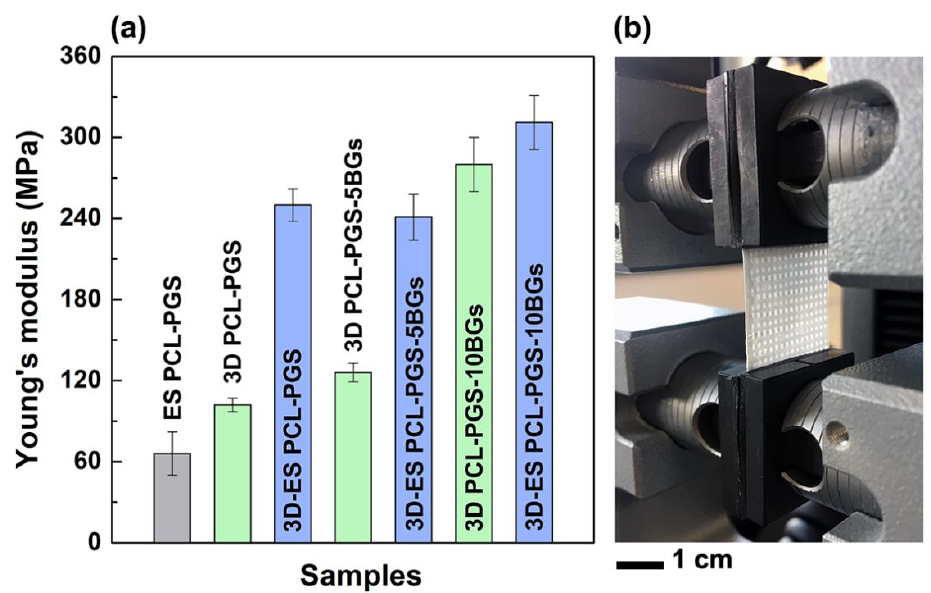
Figure 4. Values of Young’s modulus for the different scaffold types ( a ). The photograph ( b ) of one composite scaffold during the tensile test shows the 3D printed grid covered by the electrospun mat.